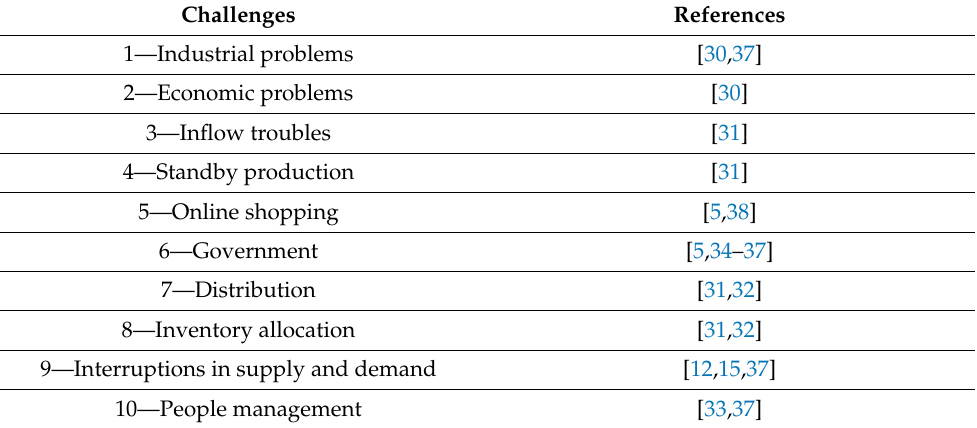
Table 1. Challenges in supply chain